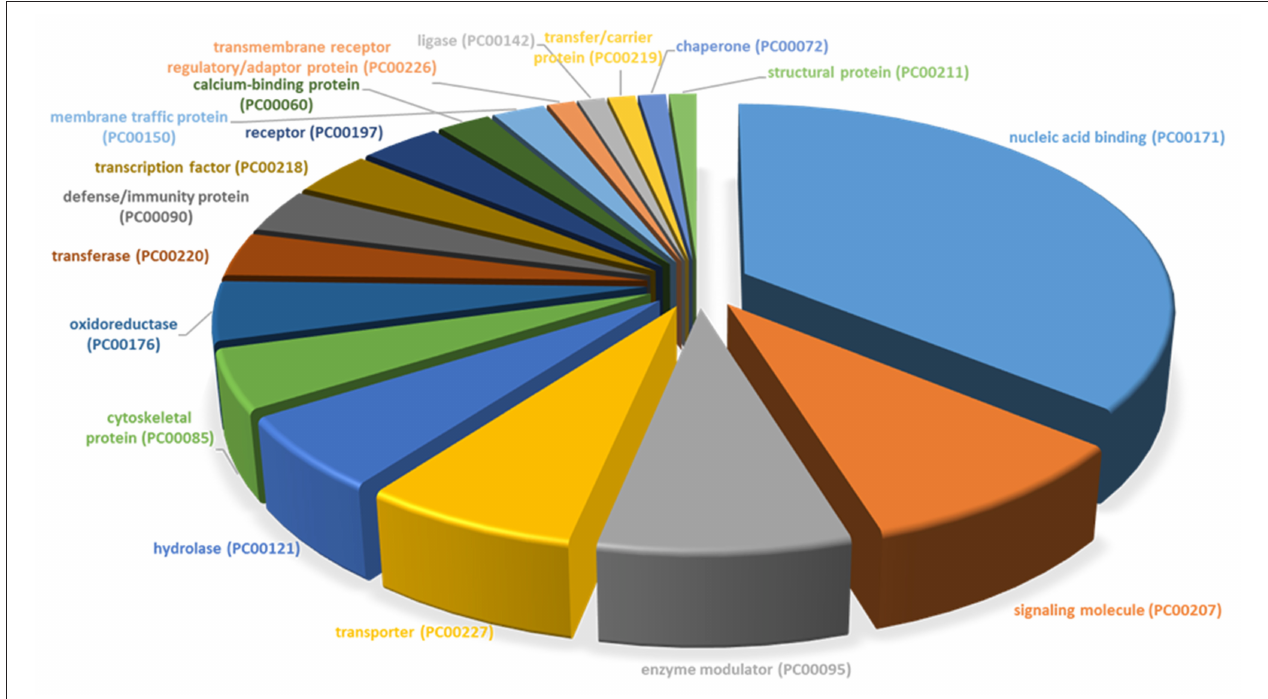
FIGURE 3 | PANTHER protein class categories of total DEGs in TRAMP mice and non-transgenic littermates. Pie chart of the broad biological functions associated with differentially expressed proteins in the prostates of TRAMP mice and non-transgenic littermates. Protein classes were grouped by the protein classification tool in PANTHER and major functions were categorized using human Gene Ontology and PANTHER with detailed